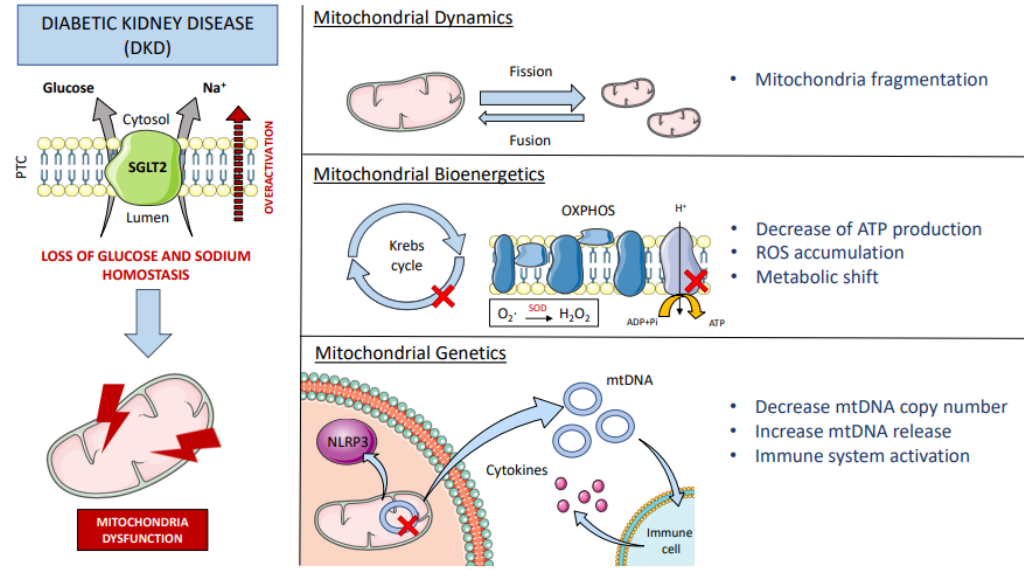
Figure 2. Mitochondrial dysfunction in DKD. The sodium/glucose co-transporter type 2 (SGLT2) is located in the apical membrane of the proximal tubular cells (PTC) of the kidney and is responsible for glucose and sodium uptake. Diabetic patients have overactivation of SGLT2 that alters glucose and sodium homeostasis, which directly affects mitochondrial function at different levels; imbalance of fission and fusion together with mitochondrial fragmentation (mitochondrial dynamics).